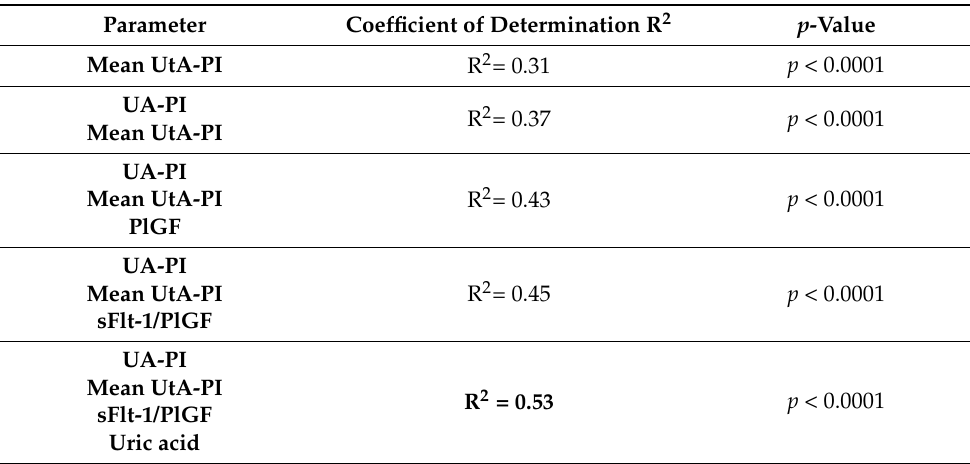
Table 6. Multiple regression analysis of the effects of ultrasound and biochemical parameters on birth